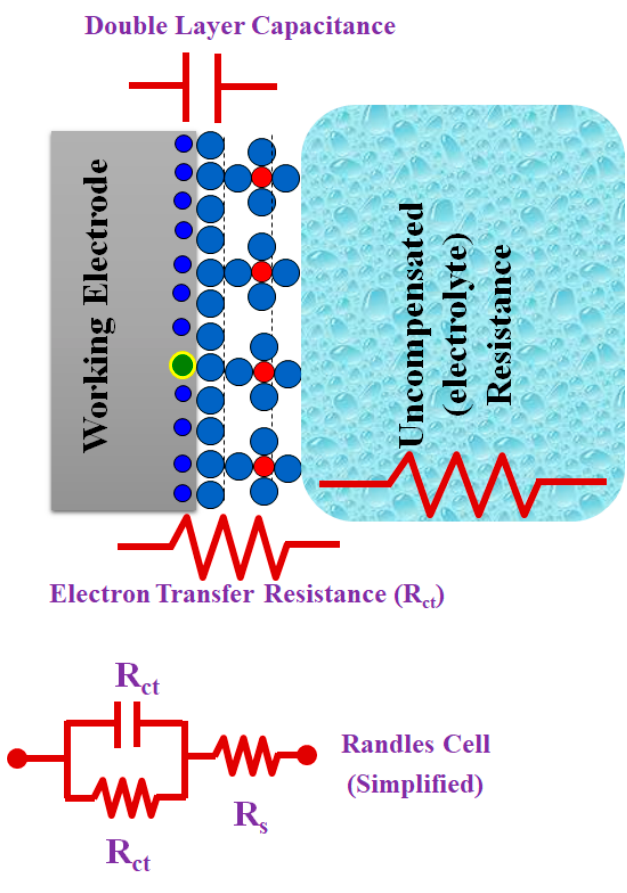
Figure 1. A simple scheme to descript the EIS circuit and the redox reaction takes place at the surface of working electrodes in a conventional-electrochemical cell (i.e., three-electrode system). R ct is the charge transfer resistance, R s is electrolyte resistance, and C dl is the capacitance double layer. The correlation between the radial frequency ( ω ) and the applied frequency (f) is calculated by Equation (3): In a linear system, the signal is shifted in phase ( Φ ) and has a different amplitude than I 0 (Equation (4)).